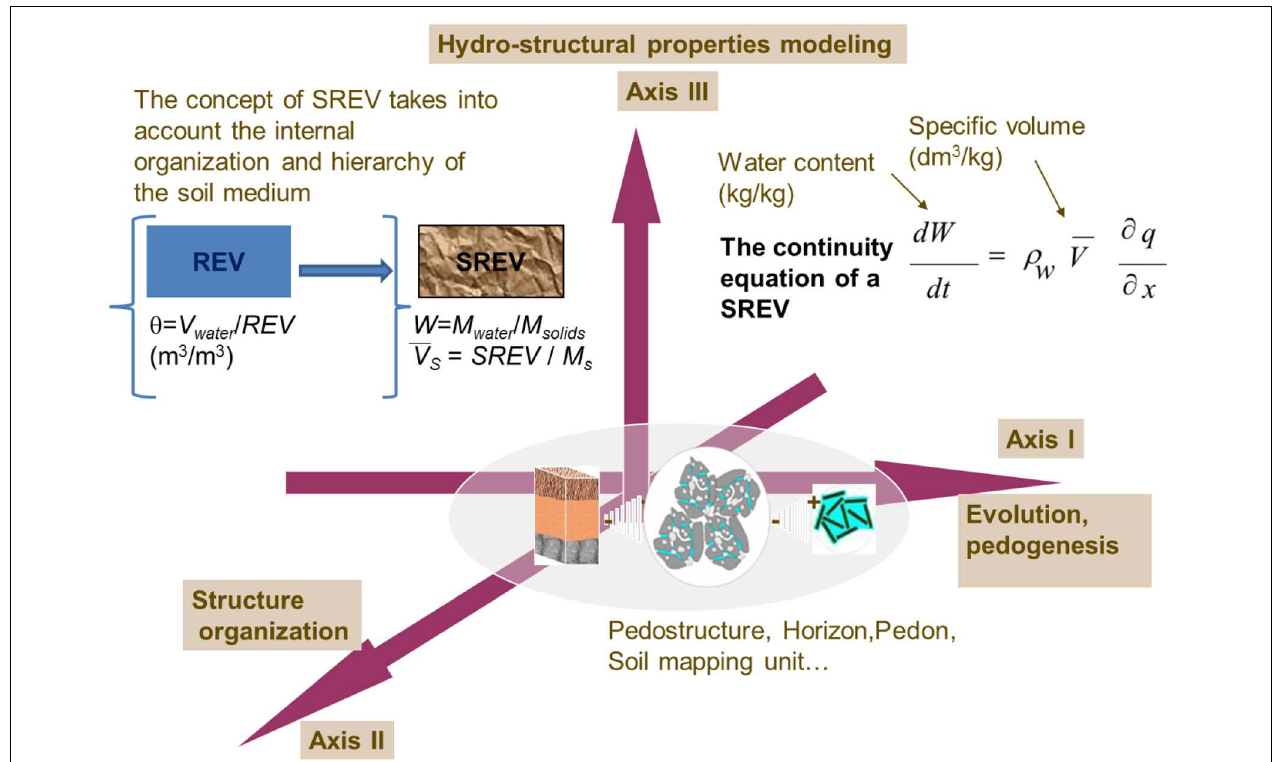
FIGURE 1 | Fundamental difference between REV and SREV concepts after Braudeau and Mohtar